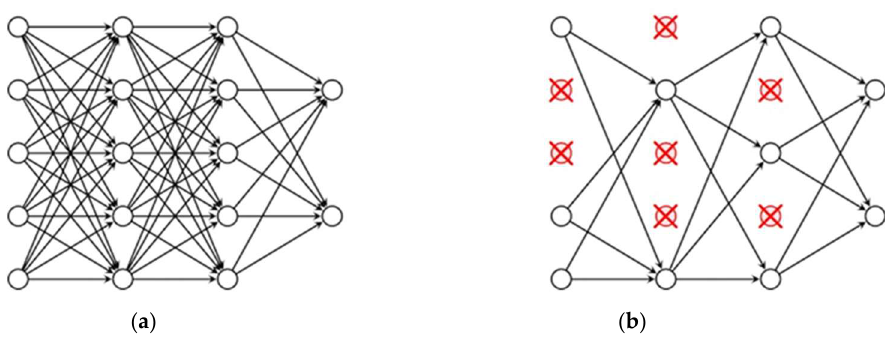
Figure 5. Dropout deep neural network model: ( a ) A standard network with two hidden layers; ( b ) the network after applying dropout.